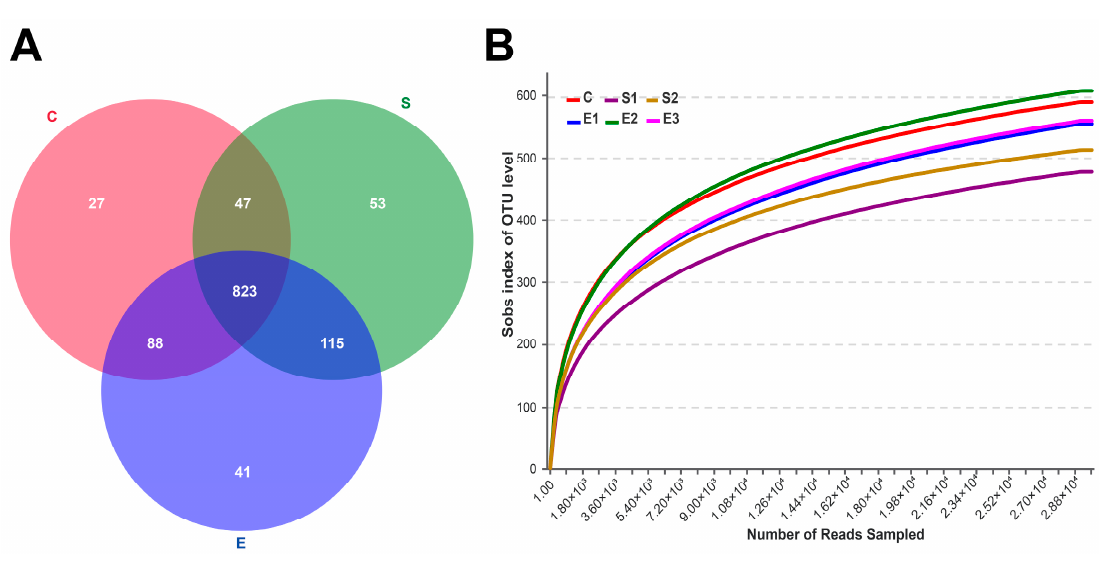
Figure 1. Sequences across different dietary groups ( A ) A Venn diagram illustrating the overlap of bacterial OTUs at a 3% dissimilarity level for Groups C, S and E. Group C samples included goats that were fed a typical total mixed ration (TMR), and Group S samples included goats that were fed a typical TMR supplemented with 10% or 15% sun ‐ dried mulberry leaves (Groups S1 and S2). Group E samples included goats that were fed a typical TMR supplemented with ensiled mulberry leaves (Groups E1 , E2 and E3). ( B ) Rarefaction analyses of the different samples. Rarefaction curves of OTUs clustered at 3% divergence.